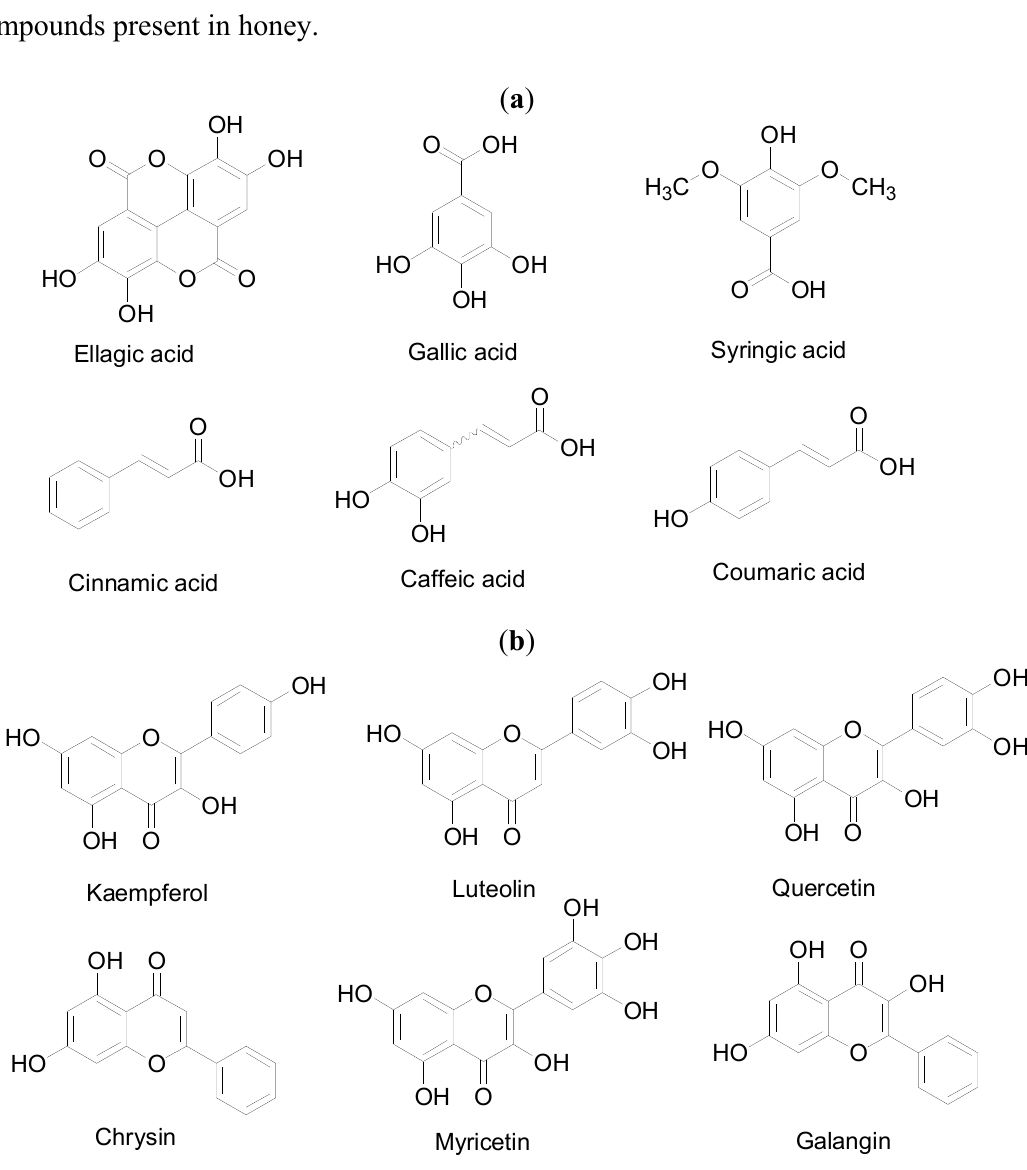
Figure 2. Molecular structures of some of the organic acids, flavonoids and phenolic compounds present in